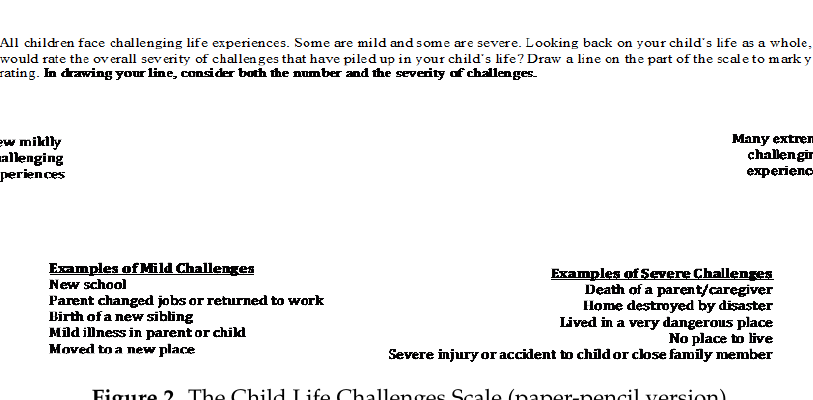
Figure 1. The Child Life Challenges Scale (tablet version).